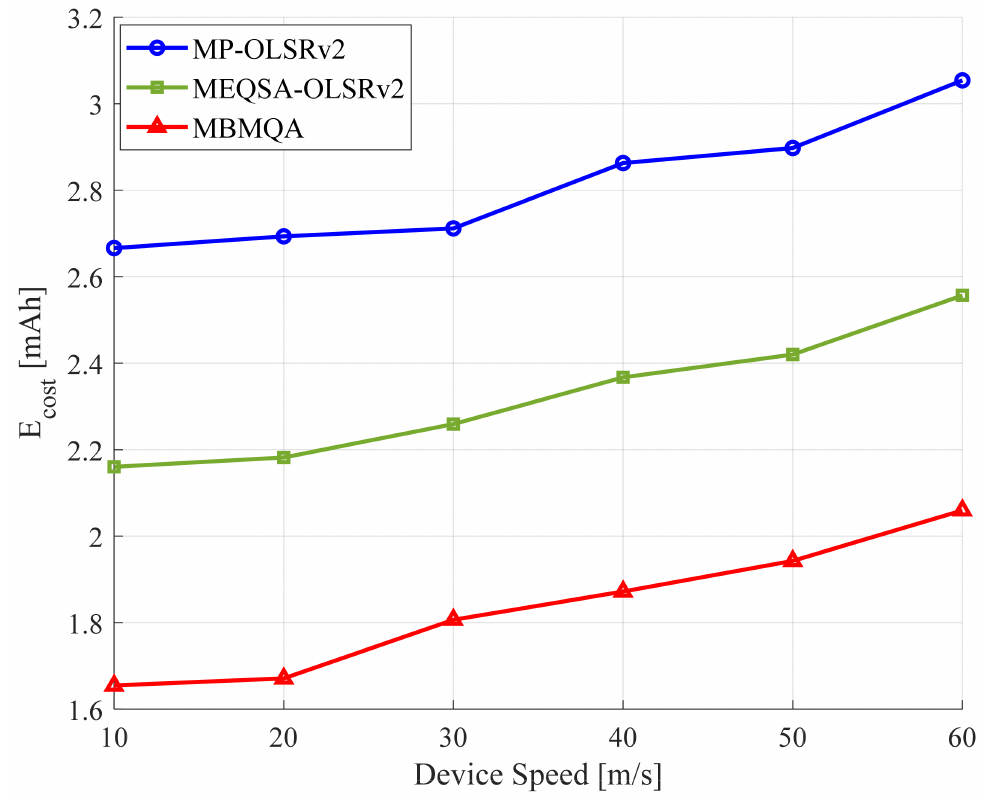
Figure 8. Energy cost packet for various node speeds.